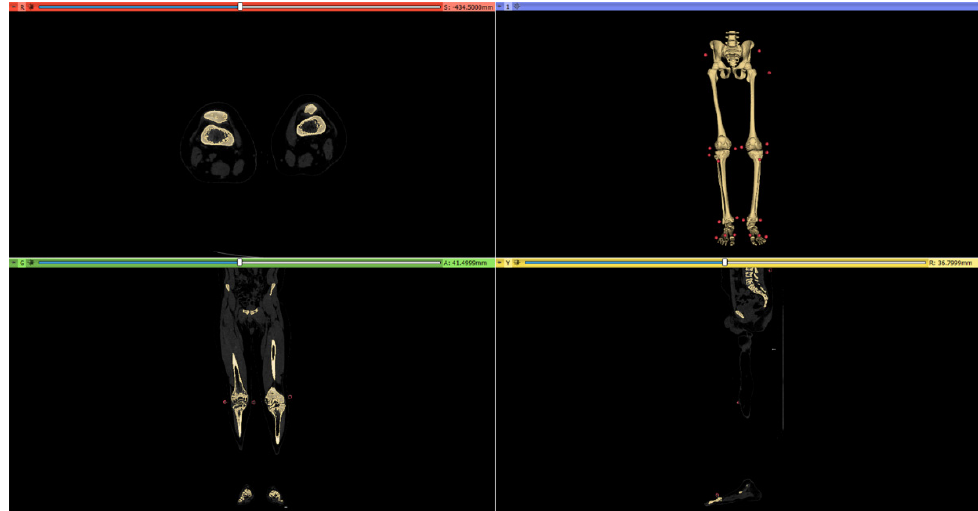
Figure 2. 3D Modelling workflow. Figure 3. CT scan reconstruction using 3DSlicer. The brightness was set to 400 and contrast to 1000. For bone tissue reconstruction was selected a range of pixel intensity between 150 and 3264, while for the markers a range between 250 and 3264.